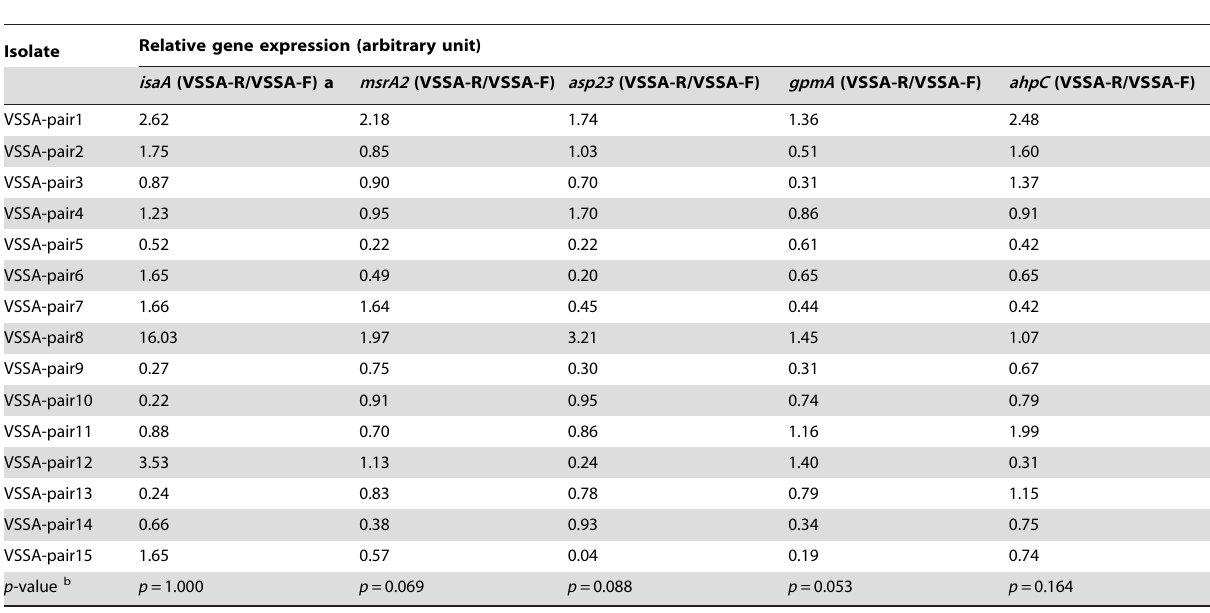
Table 5. Relative isaA , msrA2 , asp23 , gpmA and ahpC gene expression of persistent S. aureus strains, as determined by quantitative real-time–PCR and normalized to 16S rRNA expression.